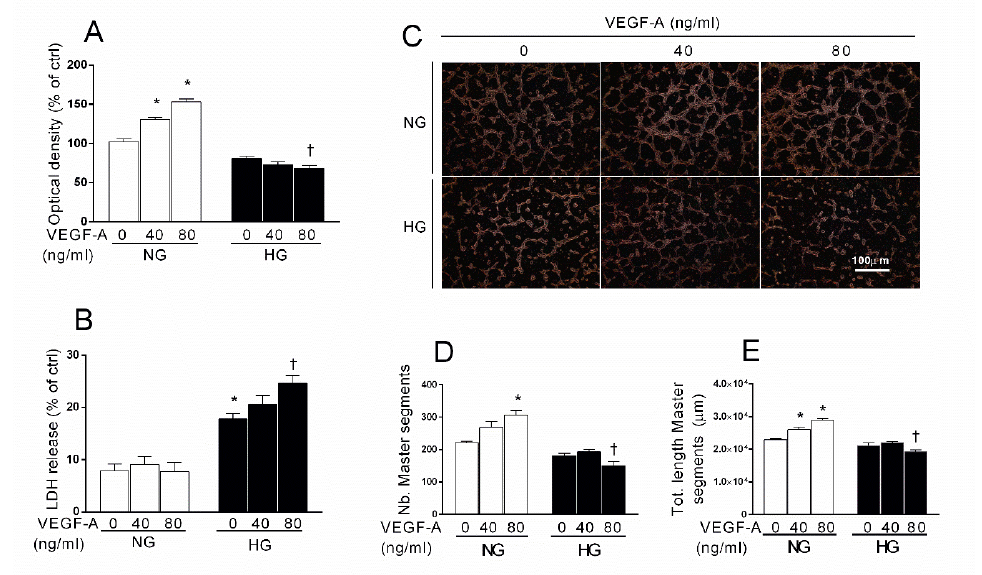
Figure 4. Exogenous VEGF-A increase damage in human retinal endothelial cells (HRECs )